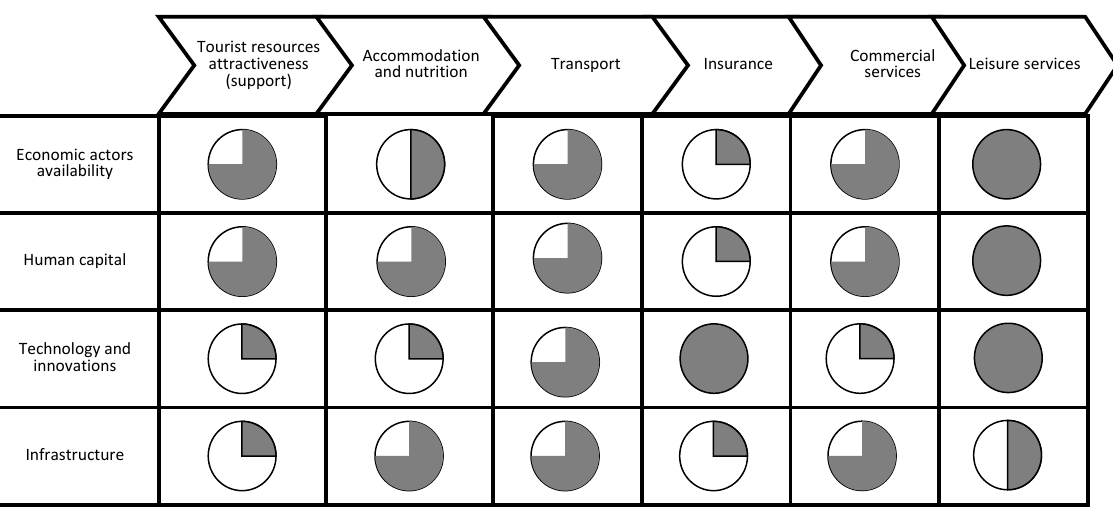
Figure 2. Example of resource mapping for tourism cluster